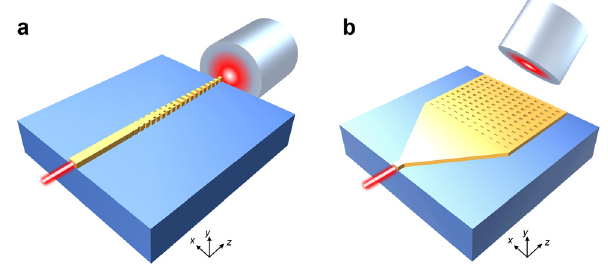
Figure 18: Schematics of SWG-based fiber-chip off-chip couplers. (a) Edge coupler with a subwavelength adiabatic transition. (b) Surface grating coupler with transverse subwavelength metamaterial patterning to apodize the radiated field